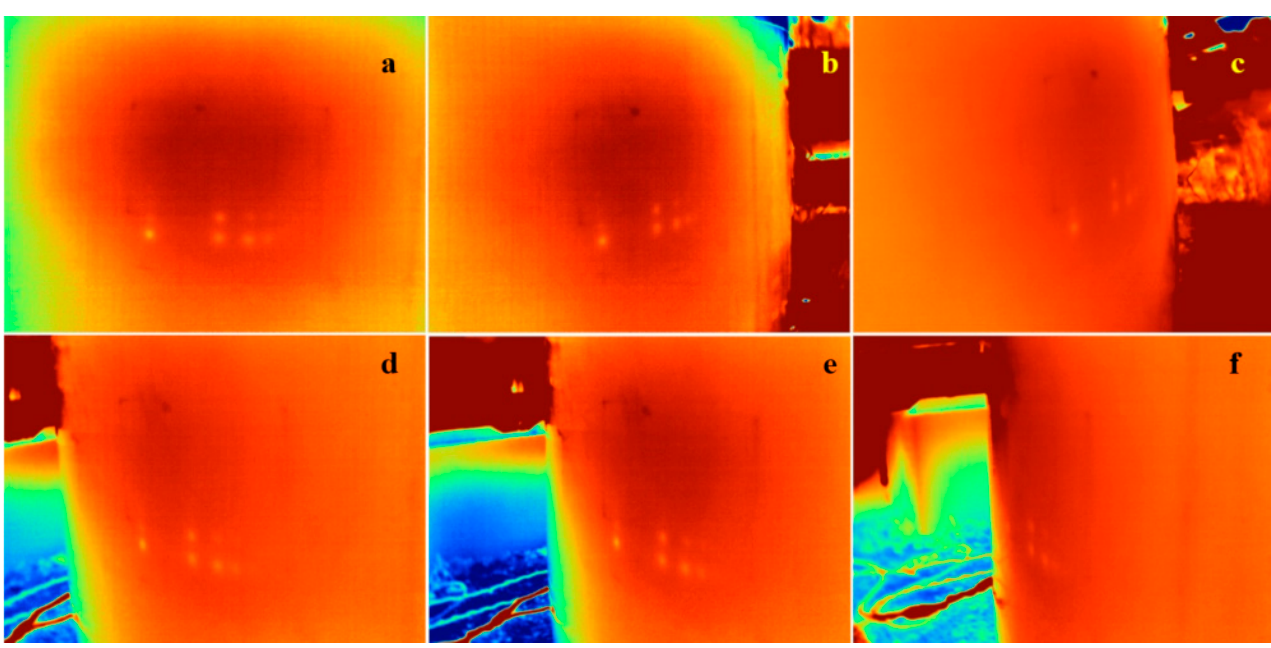
Figure 13. Thermograms captured from different angles of view: ( a ) 0°, ( b ) 30°, ( c ) 60°, ( d ) − 30°, ( e ) − 60°, and ( f ) − 75°.